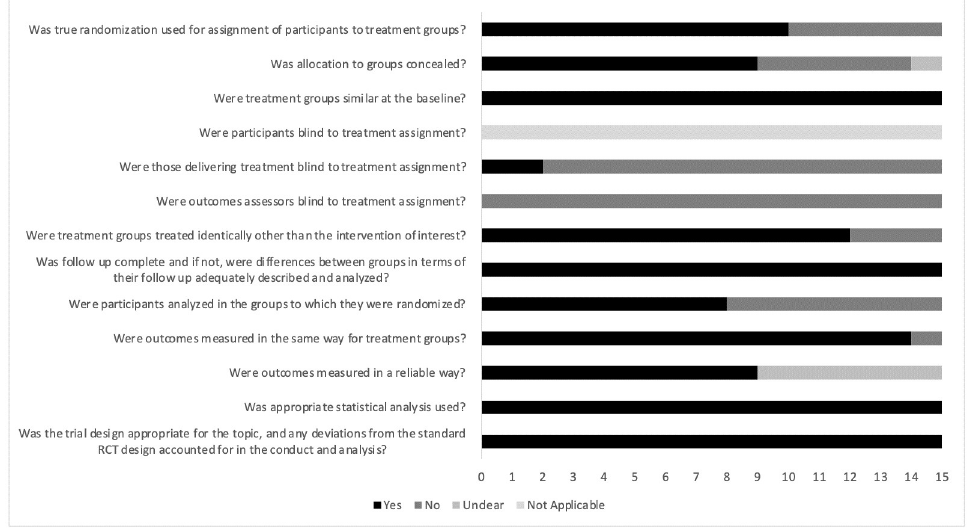
Fig 2. Risk of bias in the included studies (The Joanna Briggs Institute checklist for randomized controlled trials).